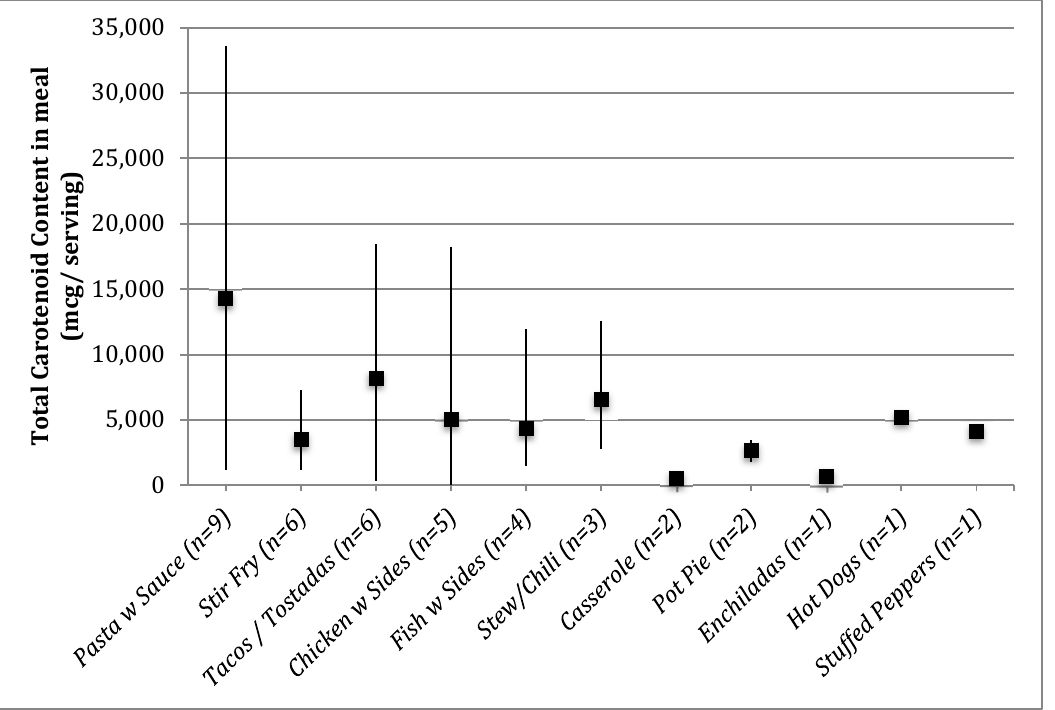
Figure 1. Scheme depicting means (as indicated by solid squares) and range (as indicated by solid lines) of carotenoid content per serving in prepared meals. () indicate the number of families that prepared a given category of dish.